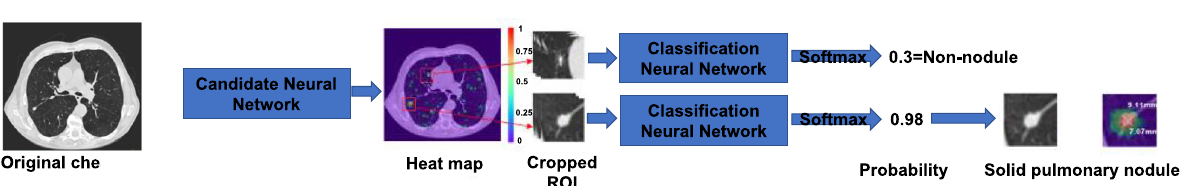
Figure 2. Schematic representation of deep neural network architecture.